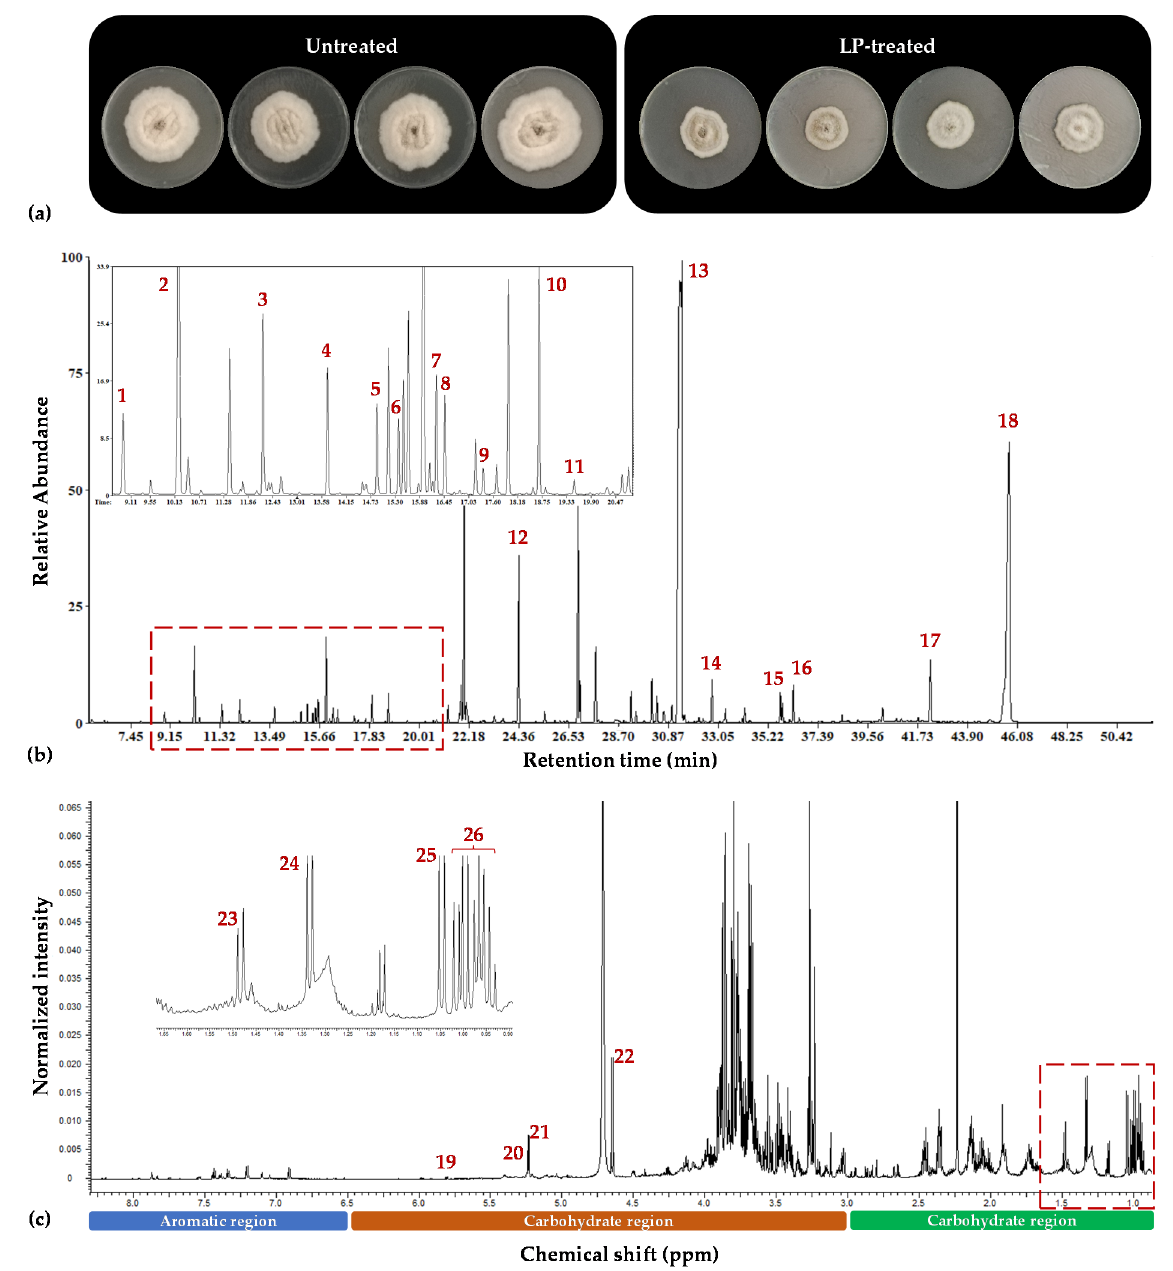
Figure 2. Effect of olive tree endophytic Bacillus sp. lipopeptide (LP) extract on Colletotrichum acutatum metabolite pro fi le. ( a ) Representative C. acutatum cultures 17 days post-inoculation, untreated and treated with the LP extract, ( b ) representative GC/EI/MS total ion chromatogram, and ( c ) representative 1 H NMR spectrum of the fungal endo-metabolome. Magni fi cation of the red dashed areas and annotations for representative metabolites are displayed (1. Lactic acid; 2. L-Alanine; 3. L-Proline; 4. L-Valine; 5. L-Serine; 6. L-Leucine; 7. Glycine; 8. Succinate; 9. Fumarate; 10. L-Threonine; 11. β -Alanine; 12. Glutamine; 13. D-Glucose; 14. Palmitate; 15. Linoleate; 16. Stearate; 17. 1-Monopalmitin; 18. α , α -Trehalose; 19. Sucrose; 20. D-Glucose; 21. α , α -Trehalose; 22. β -Glucose; 23. L-Alanine; 24. L-Threonine; 25. L-Valine; 26. L-Leucine/L-Isoleucine).